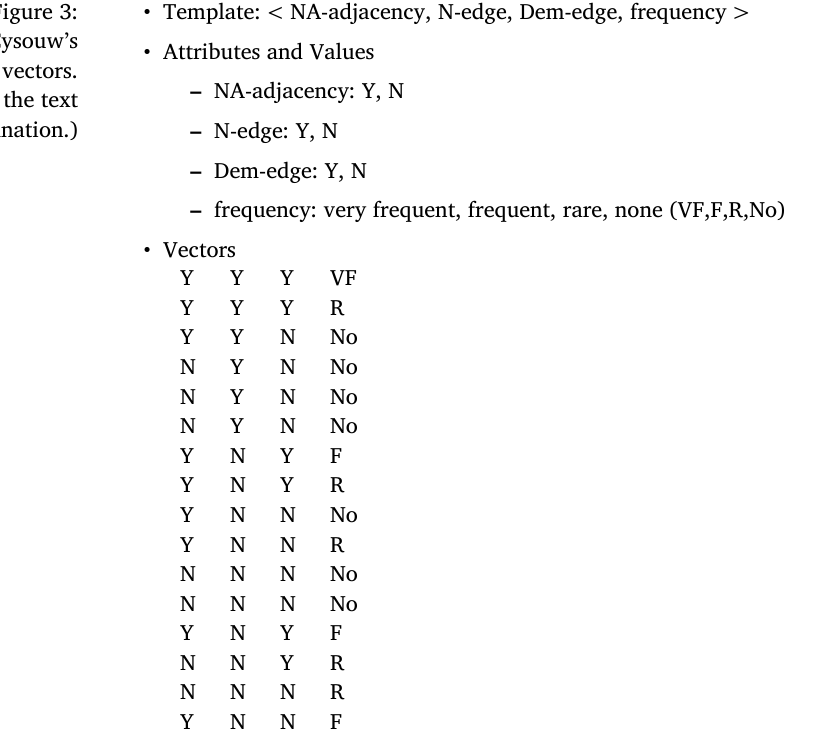
Figure 3: Cysouw’s feature vectors. (See the text for